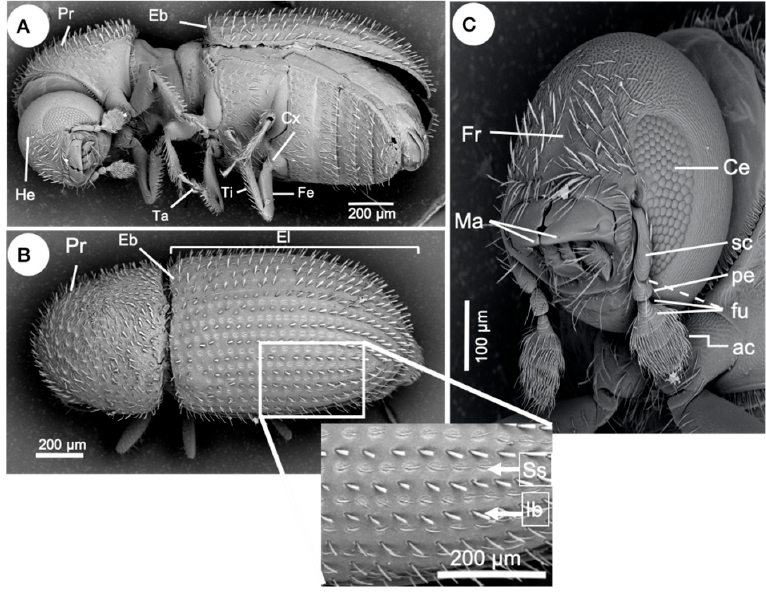
Figure 4. External anatomy of an adult of Hypothenemus hampei. ( A ) Lateral and inferior view showing pronotum (Pr), elytral base (Eb), head (He), legs with third coxa (Cx), femur (Fe), tibia (Ti), and tarsus (Ta). ( B ) Top view; detail (box) of the elytron (El) showing strial setae (Ss) and interstrial bristles (Ib). ( C ) Frons (Fr), mandibles (M), compound eye (Ce), antenna club (Ac), segmented funicle (Sf), pedicel (Pe), scapus or scape (Sc). Nomenclature according to Hulcr et al. [20] and Vega et al. [5].